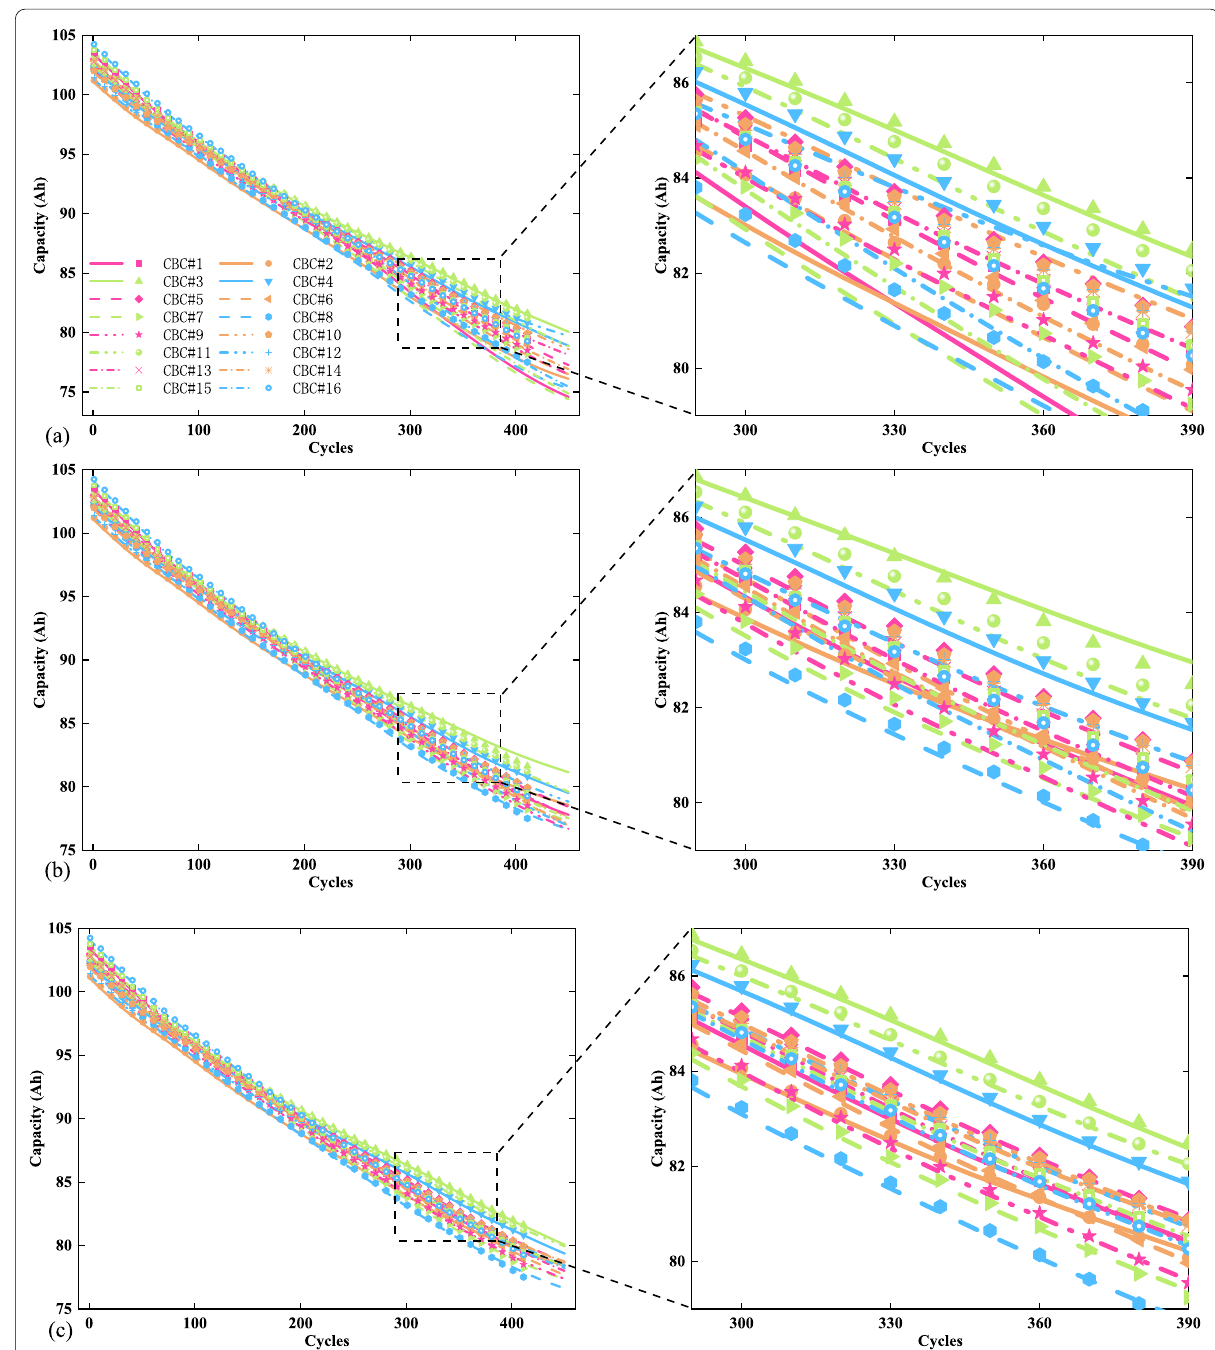
Figure 10 Future capacity distribution prediction results of the battery cells with data of the first: a 150/, b 200/, c 250 cycles is used for